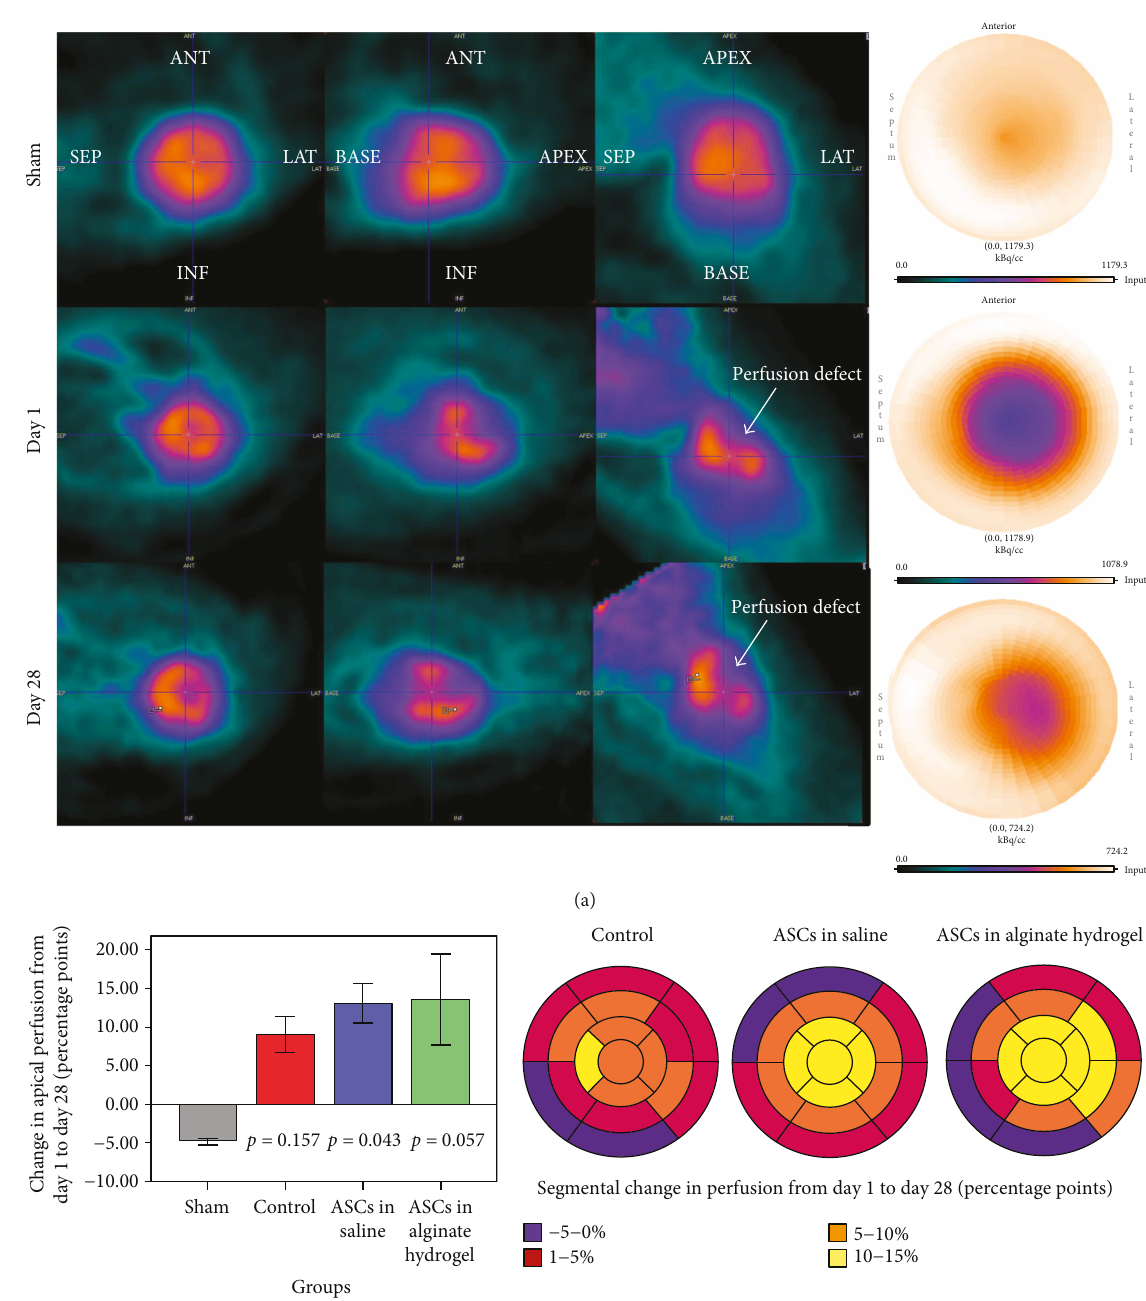
Figure 5: Perfusion. (a) 82 Rb-PET imaging of rat hearts in short axis, horizontal, and vertical view, together with a bull ’ s-eye plot of the entire left ventricle. In the upper panel is a sham heart, while a permanently ligated heart treated with ASCs in saline is shown in the middle (day 1 post MI) and lower panel (day 28 post MI). (b) Mean change in total myocardial perfusion for each group. Sample size for (b) and (c): sham =2, control =6, ASCs in saline =8, and ASCs in alginate hydrogel =3. p values denote di ff erence compared to sham. (c) Mean absolute change in relative segmental perfusion in the 17 AHA heart segments. PET: positron emission tomography; ASCs: adipose- derived stromal cells; MI: myocardial infarction; AHA: American Heart Association; ANT: anterior; LAT: lateral; SEP: septal; INF: